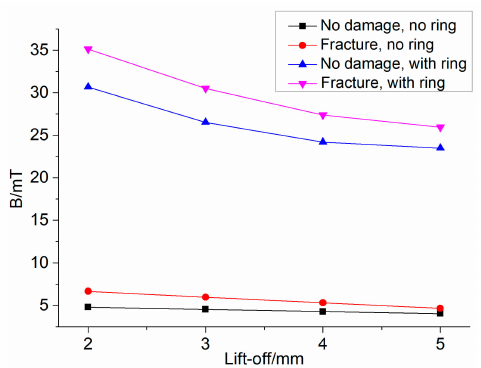
Figure 11. Magnetic flux density of Hall component under di ff erent lift-o ff